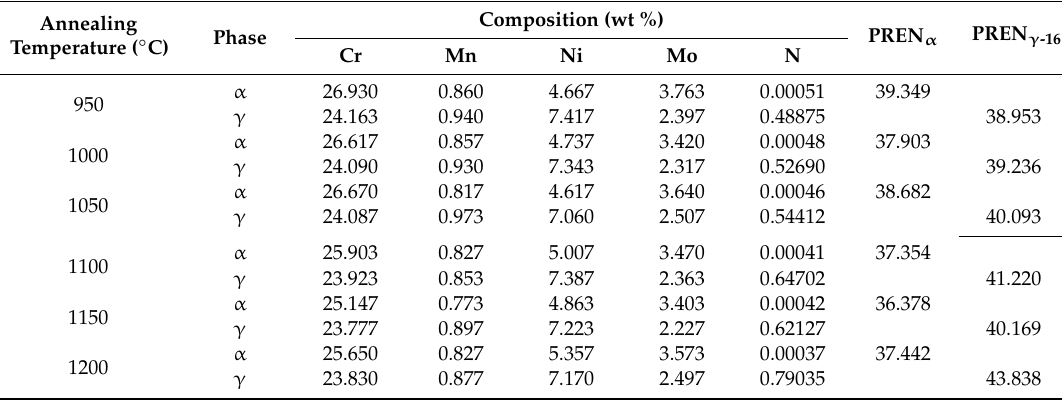
Table 1. Annealing temperature, phase fraction, element composition and pitting resistance equivalent number (PREN) values of the ferrite ( α ) and austenite ( γ ) phases of S32750 stainless steel annealed samples. PREN α = [Cr] + 3.3[Mo], PREN γ -16 = [Cr] + 3.3[Mo] + 16[N] – [Mn]